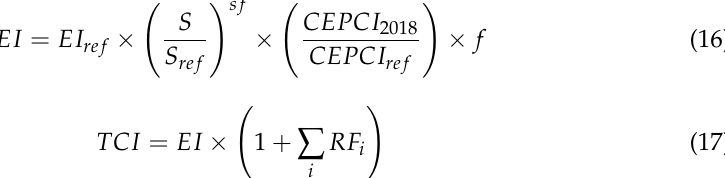
Table 5. Reference equipment investment of each unit.